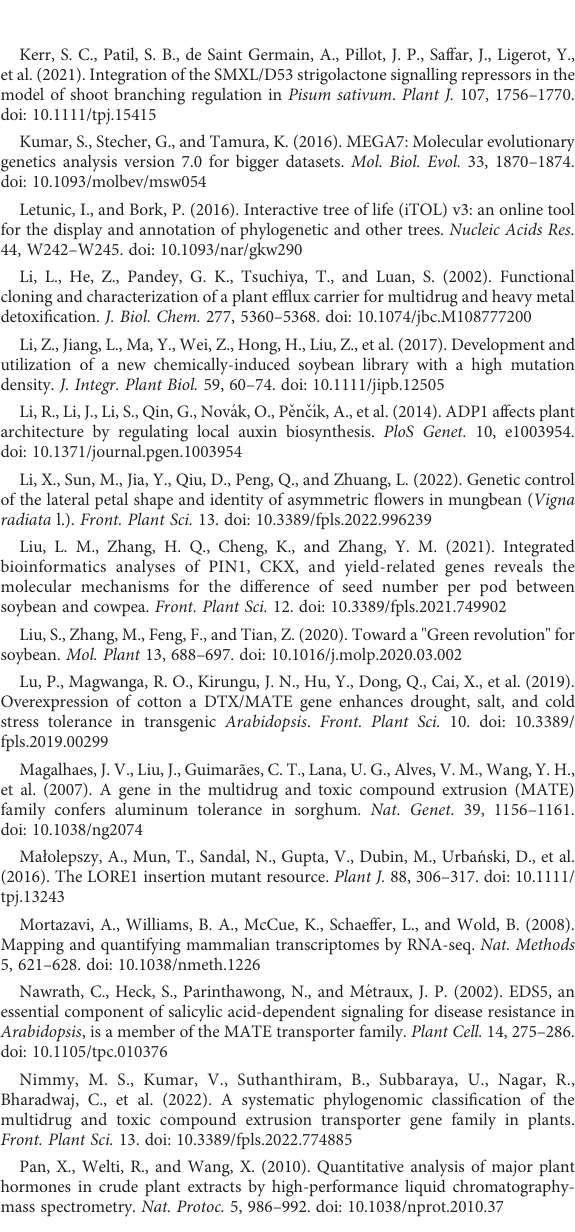
SUPPLEMENTARY TABLE 3 DEGs in shoot buds between WT and mib1 mutants.